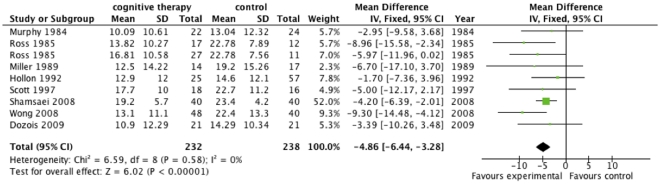
The effect of cognitive therapy versus ‘no intervention’ at cessation of treatment on Becks Depression Inventory (BDI).